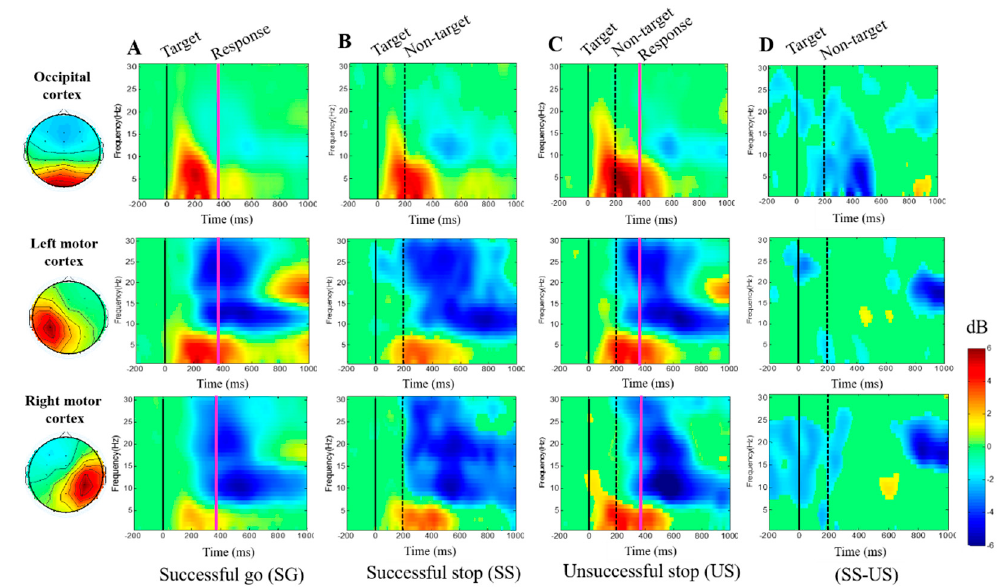
Figure 6. Averaged ERSP of all subjects in the occipital cortex, left motor cortex and right motor cortex under ( A ) successful go, ( B ) successful stop, ( C ) unsuccessful stop, and ( D ) successful stop vs. unsuccessful stop. In the successful go condition, the black line indicates the go cue (target) stimulus; the pink line indicates response time. In the successful stop conditions, the dashed black line indicates stop-signal (non-target). Right color bar shows the ERSP in decibels (dB); statistical threshold at p < 0.05.